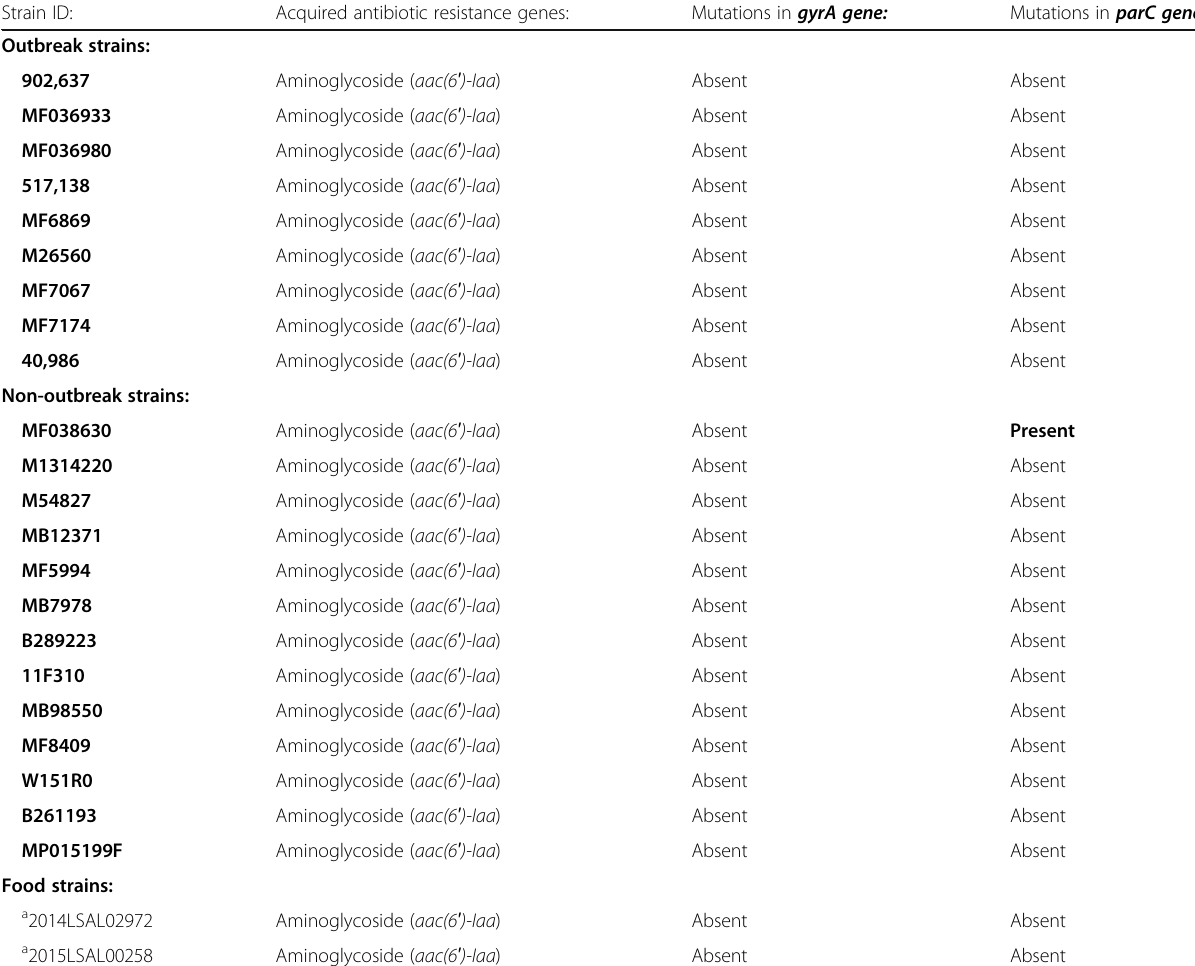
Table 7 In silico analyses results of antimicrobial resistance genes and mutations within all Salmonella Dublin strains Strain ID: Acquired antibiotic resistance genes: Mutations in gyrA gene: Mutations in parC